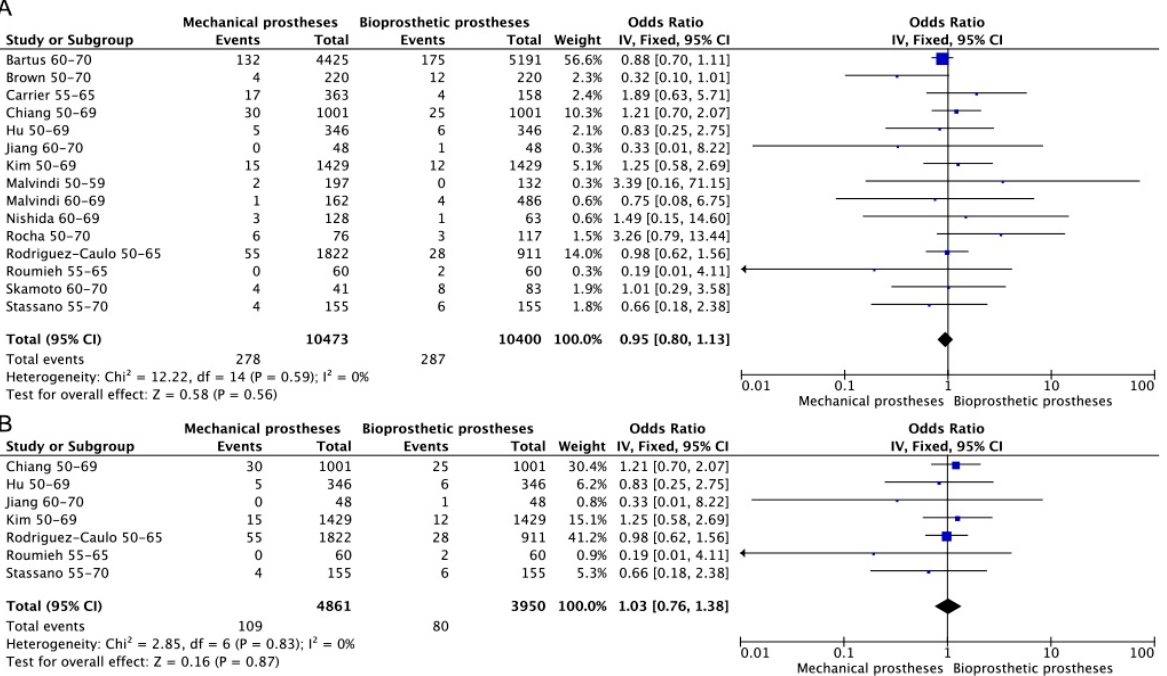
Figure 2. Meta ‐ analysis for early mortality. ( A ) Bioprosthetic vs. mechanical. ( B ) Bioprosthetic vs. mechanical (RCT or PSM).